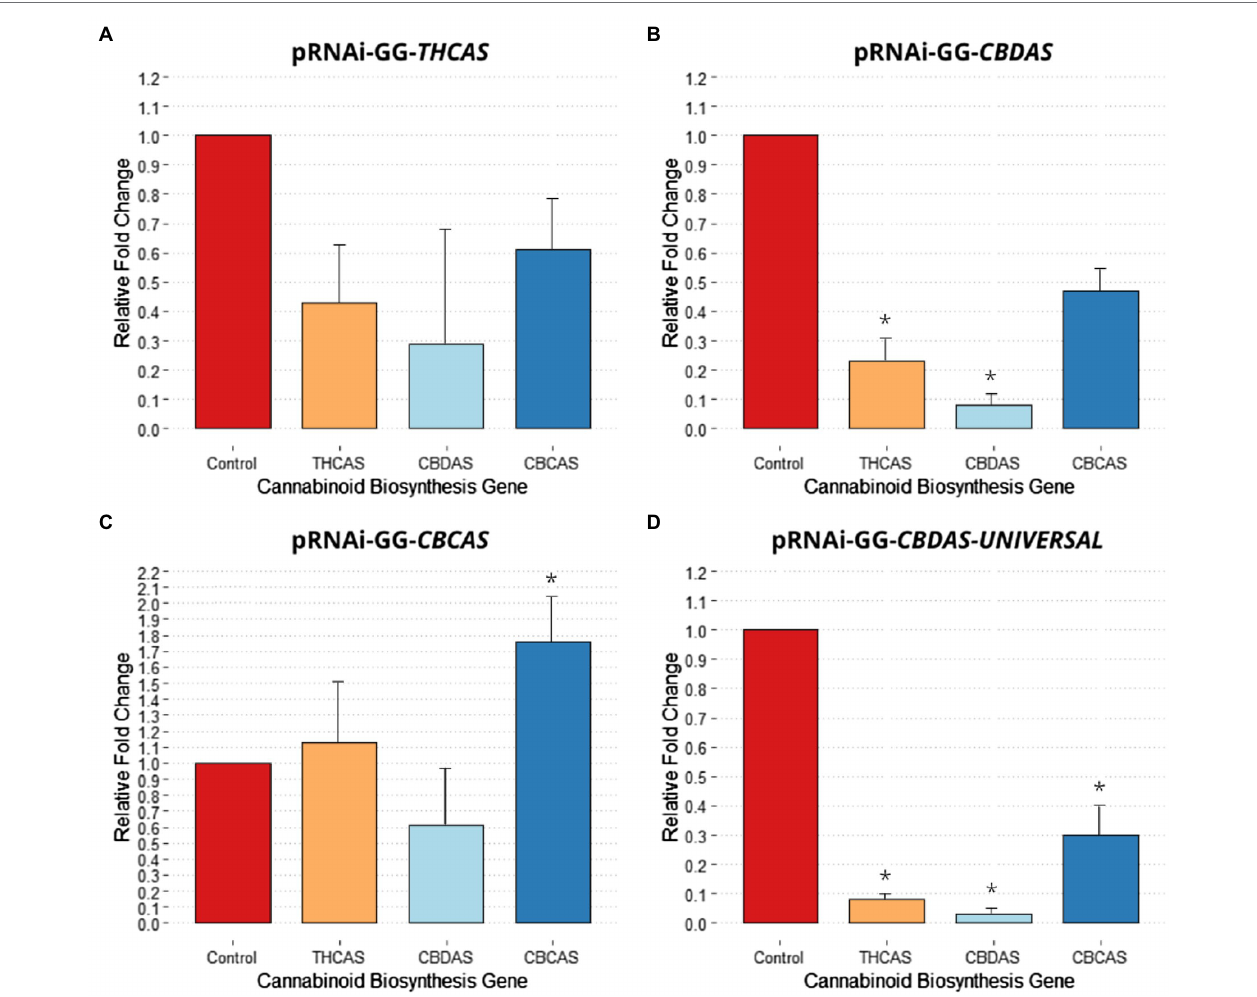
FIGURE 3 | Effect of different pRNAi-GG vectors on cannabinoid biosynthesis gene relative expression change. (A) Relative fold change post agroinfiltration with pRNAi-GG- THCAS . (B) Relative fold change post agroinfiltration with pRNAi-GG- CBDAS . (C) Relative fold change post agroinfiltration with pRNAi-GG- CBCAS . (D) Relative fold change post agroinfiltration with pRNAi-GG- CBDAS - UNIVERSAL . Significance is determined by paired t -test, ( p < 0.05) is denoted by *. Error bars represented